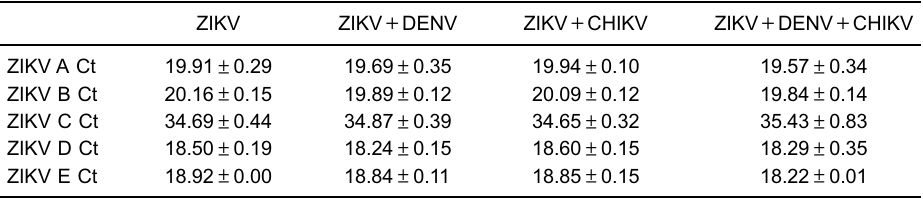
Table 2. Cycle threshold of primers/probes protocols used to test the presence of Zika virus (ZIKV) in coinfected